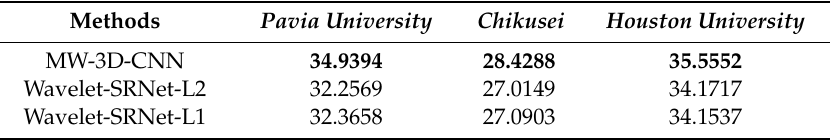
Table 10. PSNR (dB) of MW-3D-CNN and wavelet-SRNet with upscaling factor two.